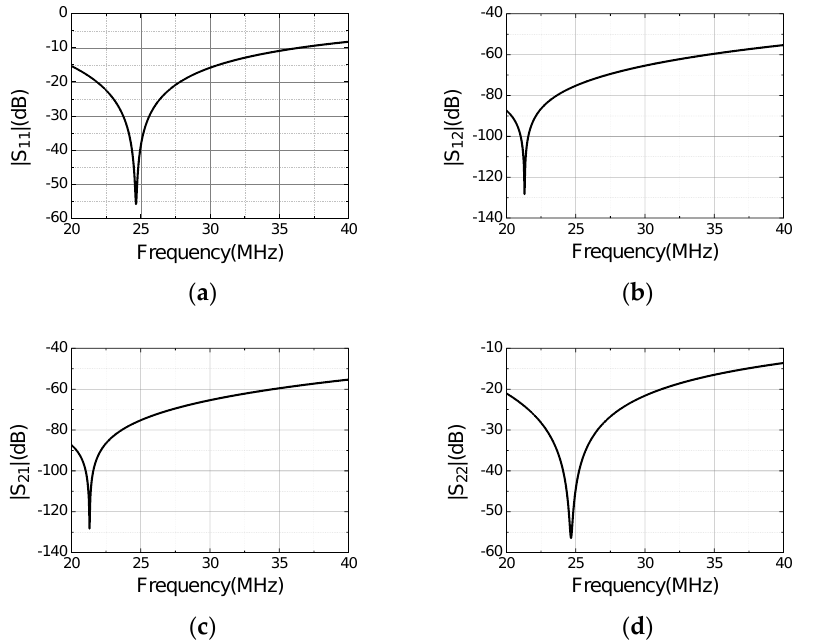
Figure 9. The S − parameters of the remote resistance matching for the orthogonal dual-coil probe ( a ) S 11 ; ( b ) S 12 ; ( c ) S 21 ; ( d ) S 22 .